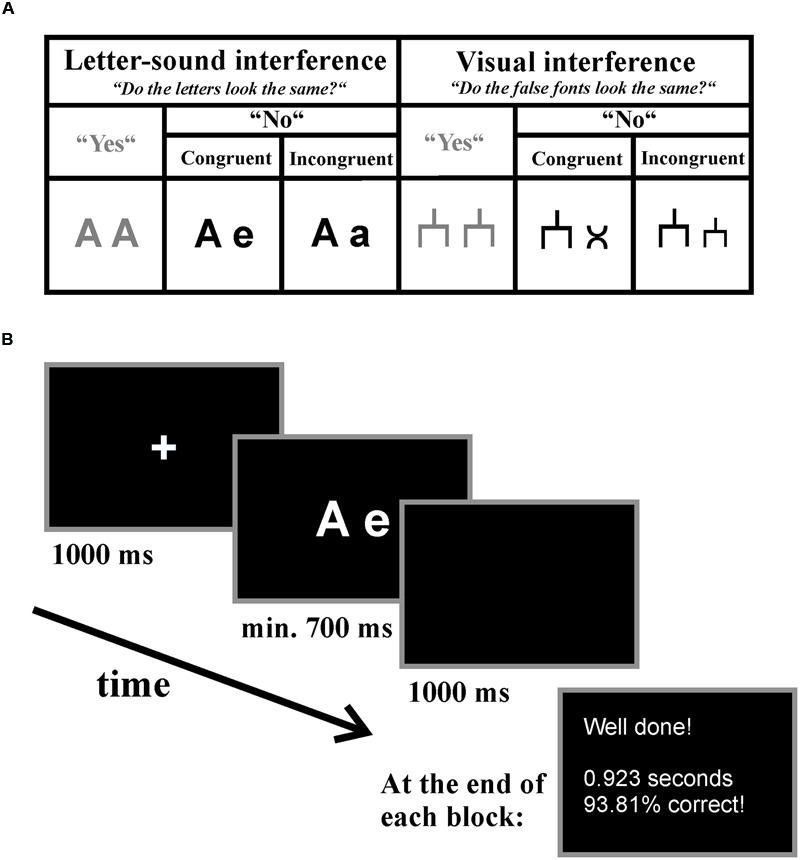
Letter-speech sound interference and visual interference task. (A) Experimental conditions and an example of the presented stimuli in each condition listed separately for the tasks. (B) An example trial of the letter-speech sound interference experiment. Participants were instructed to decide via button-press whether the presented stimuli looked visually the same and received feedback about their general performance at the end of each block.